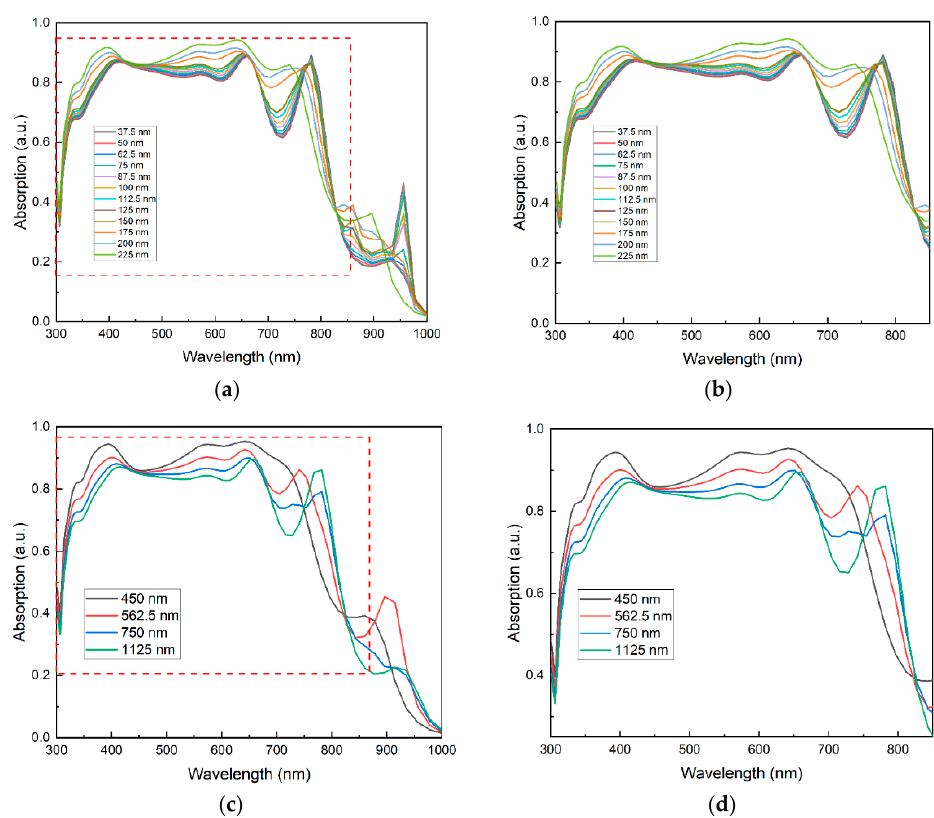
Figure 2. The absorption spectra for every layer in this structure.